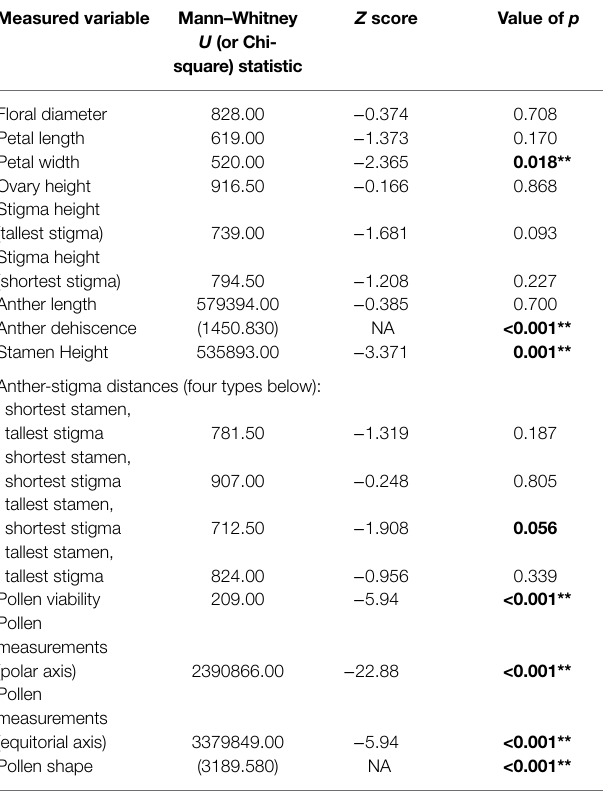
TABLE 3 | Summary of statistics resulting from Mann–Whitney U and Chi-square tests conducted to determine significant differences between the characteristics of control R. acicularis flowers and those collected from operational forestry sites treated with GBH in northern British Columbia, Canada. Measured variable